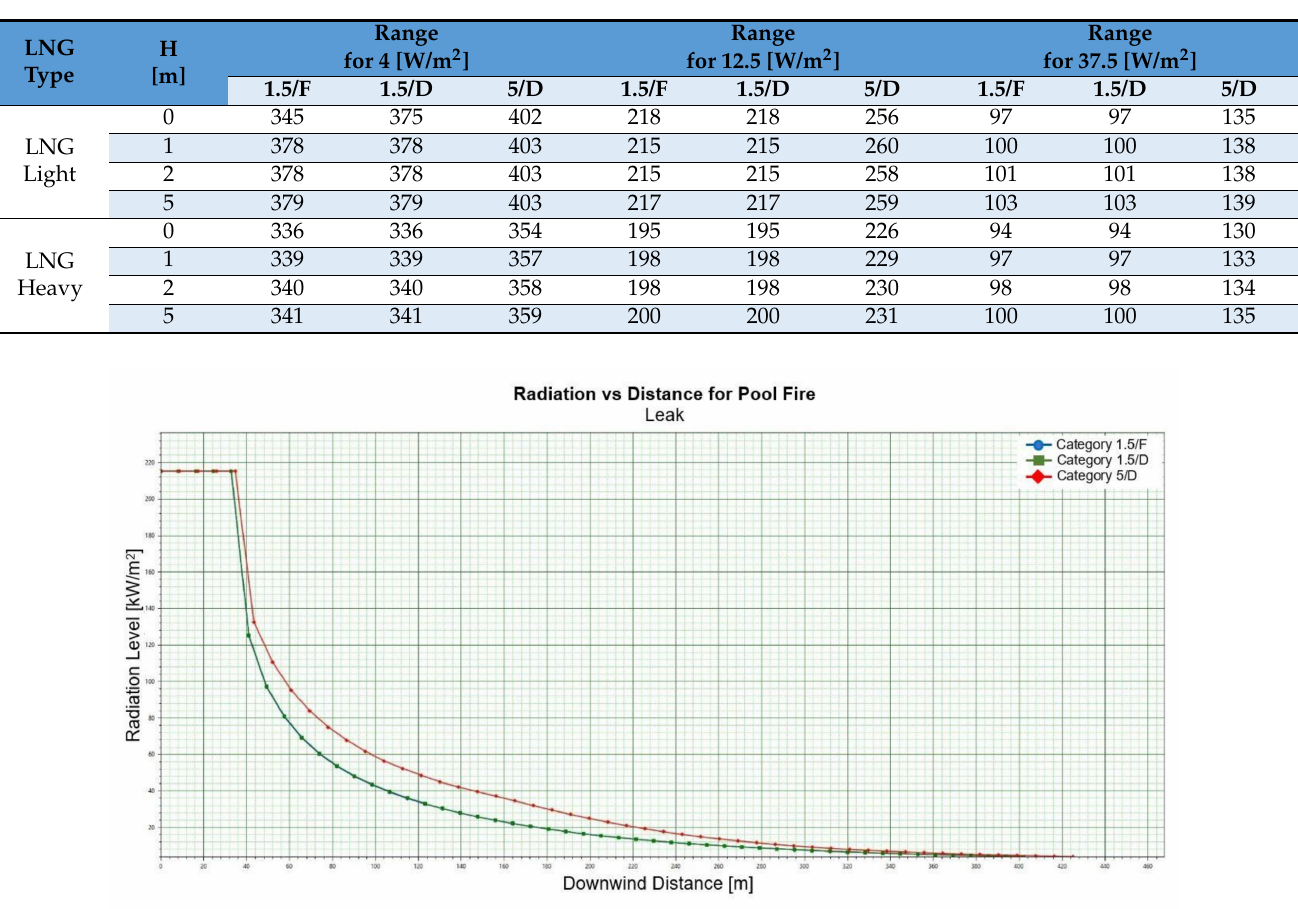
Table 11. Early pool fire, summer.